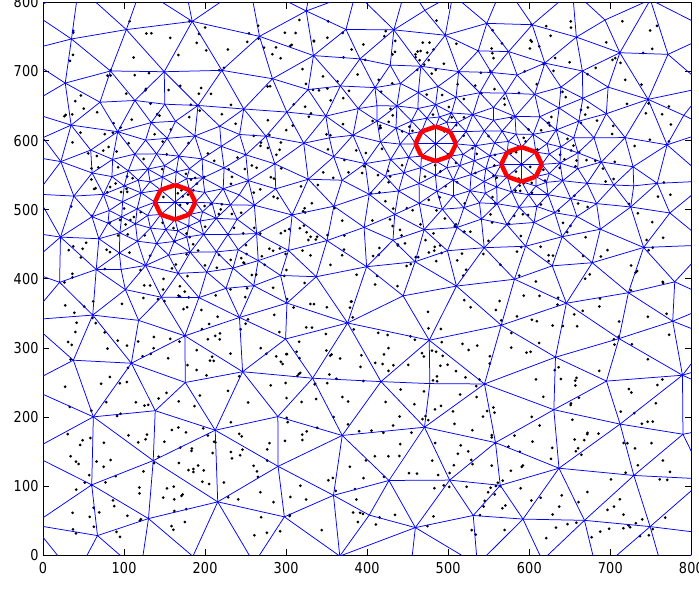
Figure 8. Random scenario with 3 heat sources and 1000 sensor